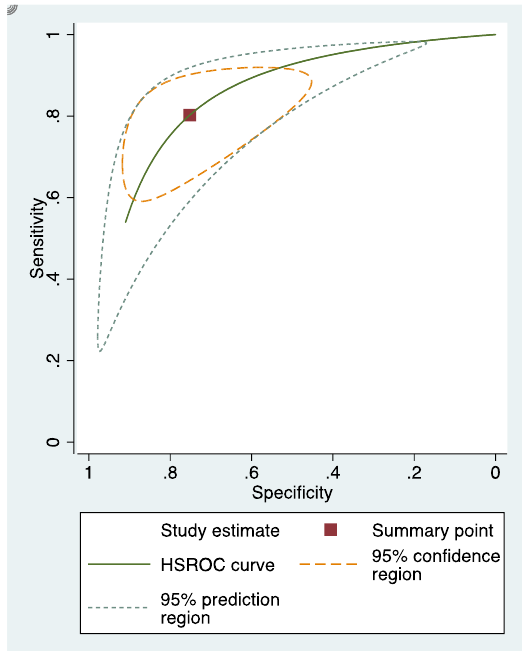
Figure 2. sRoc curves of visual inspection.